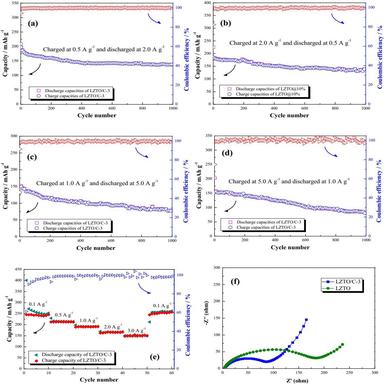
Cycling performance of LZTO/C-3 at various charge-discharge rates (a–d); Rate performance of LZTO/C-3 at different discharge rates (e); Nyquist plots of LZTO/C-3 and LZTO electrodes before cycling (f).